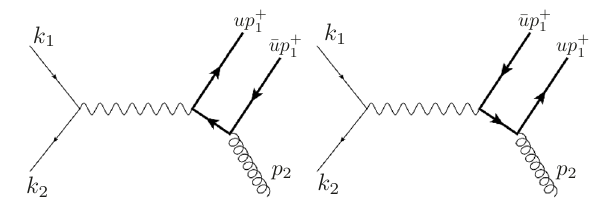
Figure 3 . Leading order Feynman diagrams for e + e (cid:0)